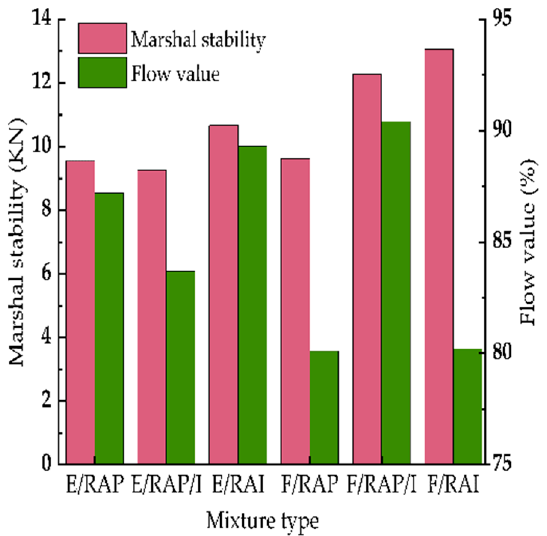
Figure 8. Water immersion Marshall stability test results.